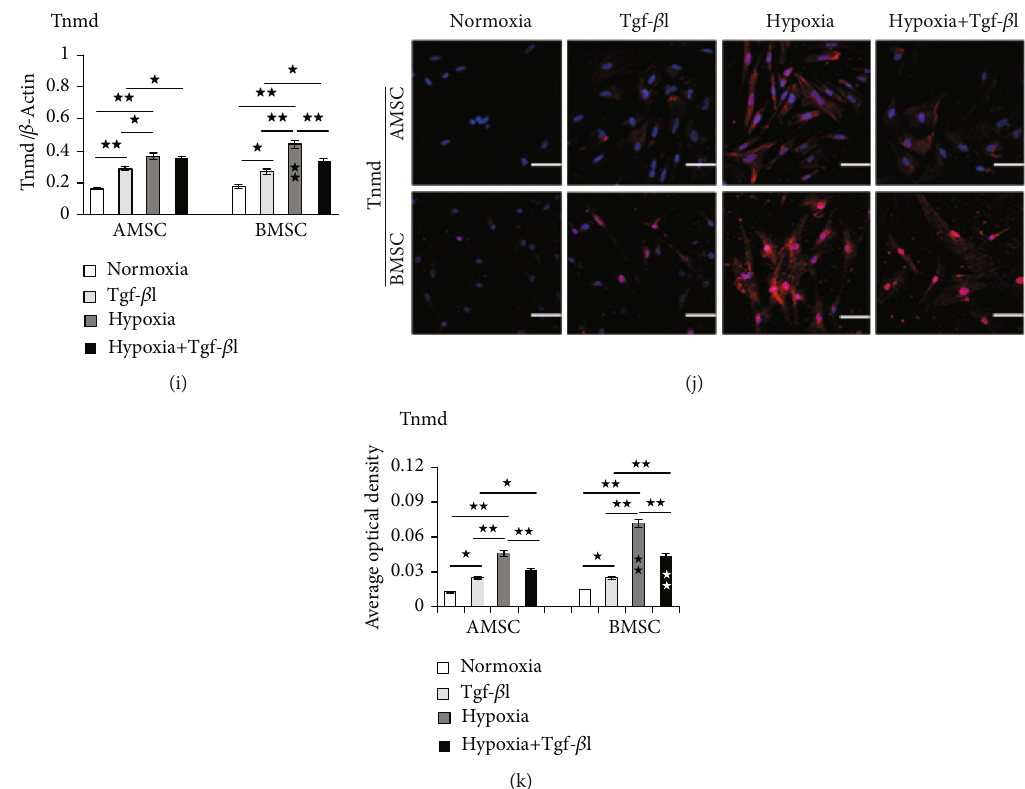
Figure 5: The mRNA and protein expressions of tenogenic markers in AMSCs and BMSCs at 7 days after induction. (a – d) qRT-PCR analysis of gene expression of Col-1a1 (a), Col-3a1 (b), Dcn (c), and Tnmd(d) under normoxia, Tgf- β 1, hypoxia, and hypoxia+Tgf- β 1 condition in AMSCs and BMSCs. (e – i) Representative western blots (e) and quanti fi cation of protein expression of Col-1a1 (f), Col-3a1 (g), Dcn (h), and Tnmd(i) under normoxia, Tgf- β 1, hypoxia, and hypoxia+Tgf- β 1 condition in AMSCs and BMSCs. Asterisks in the column in BMSCs indicated signi fi cant di ff erence from the same condition in AMSCs. (j, k) Representative immuno fl uorescence staining (j) of Tnmd (red) and DAPI-labeled nuclei (blue), and quanti fi cation data (k) under under normoxia, Tgf- β 1, hypoxia, and hypoxia+Tgf- β 1 condition in AMSCs and BMSCs. Asterisks in the column in BMSCs indicated signi fi cant di ff erence from the same condition in AMSCs. Scale bar = 50 μ m; Magni fi cation: × 400. Data were shown as mean ± SD . ★ p < 0 : 05 ; ★★ p < 0 : 01